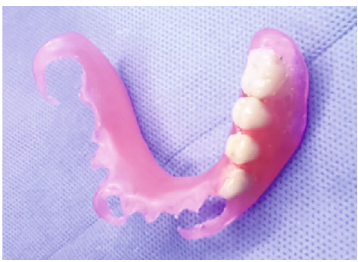
Figure 7: The fl exible denture.